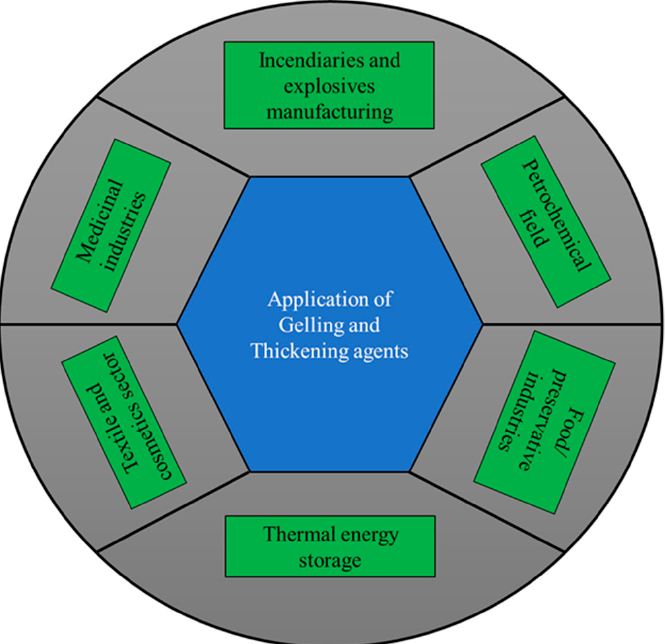
Figure 3. GTA applications in various sectors.